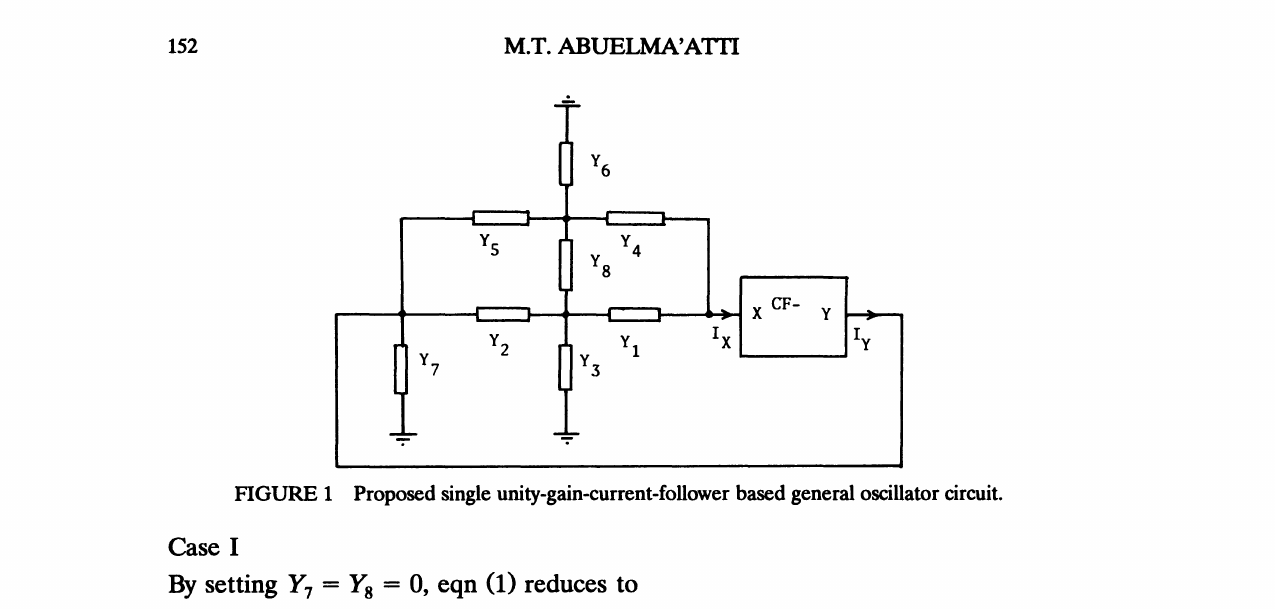
FIGURE 1 Proposed single unity-gain-current-follower based general oscillator circuit.